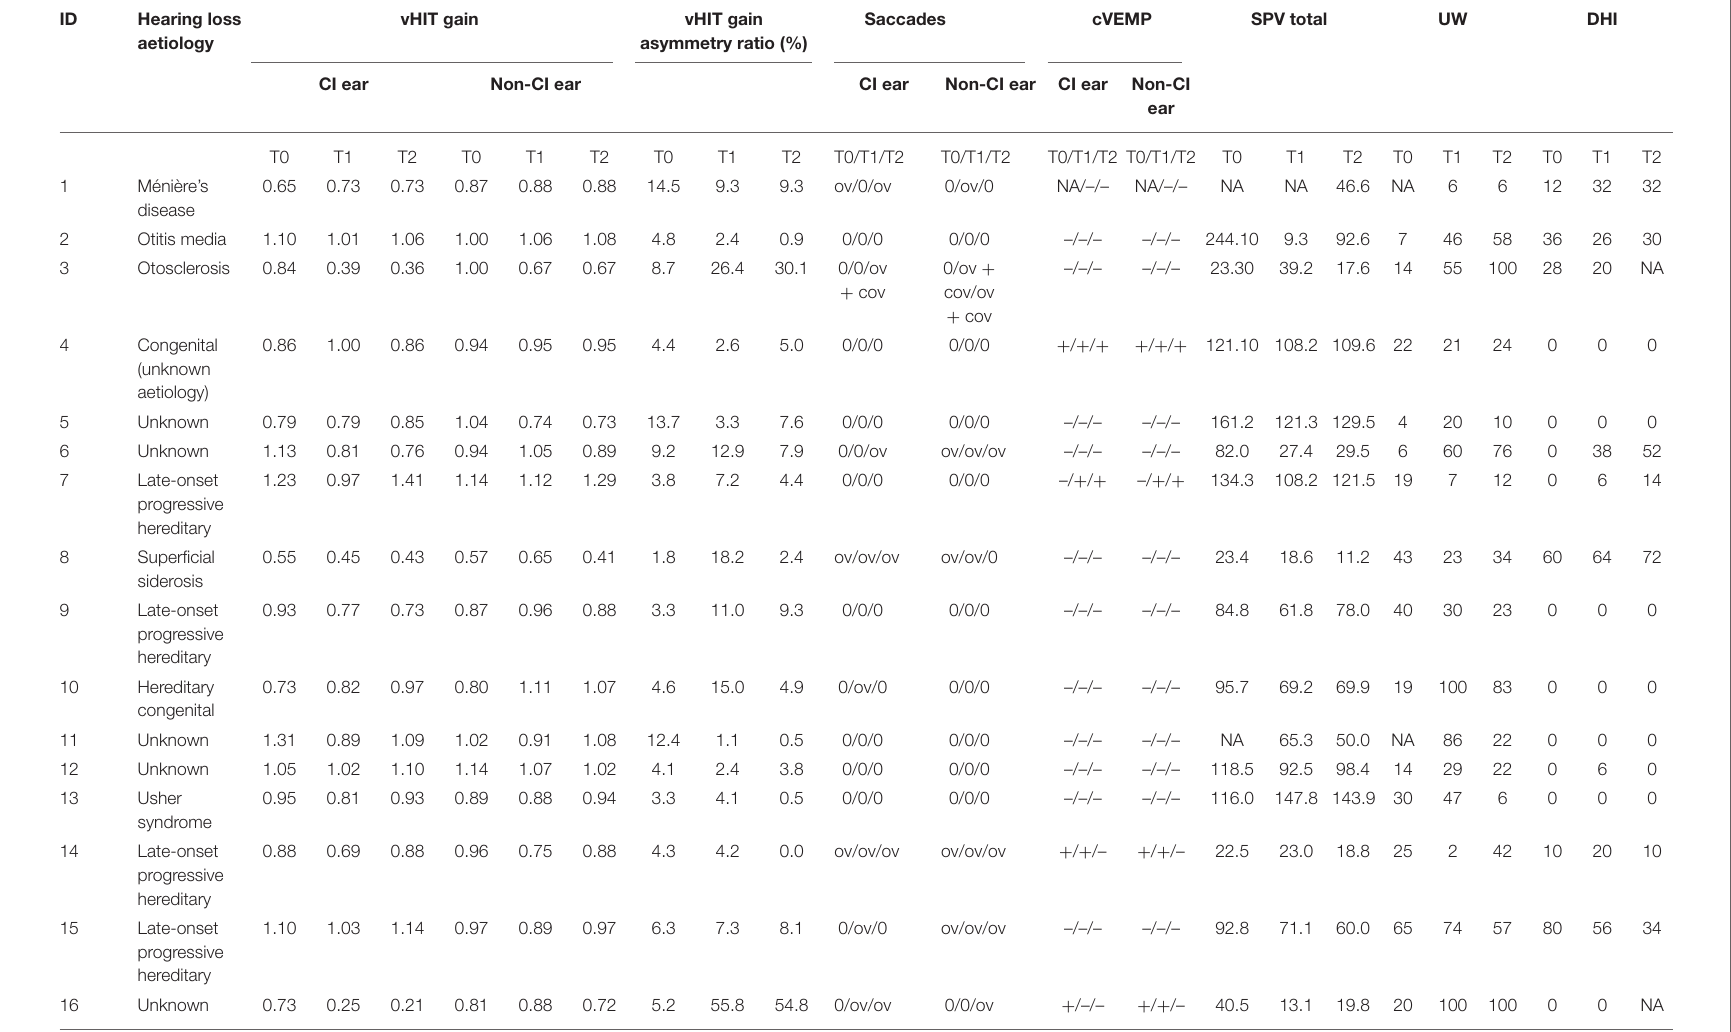
TABLE 2 | Complete raw data set on all 35